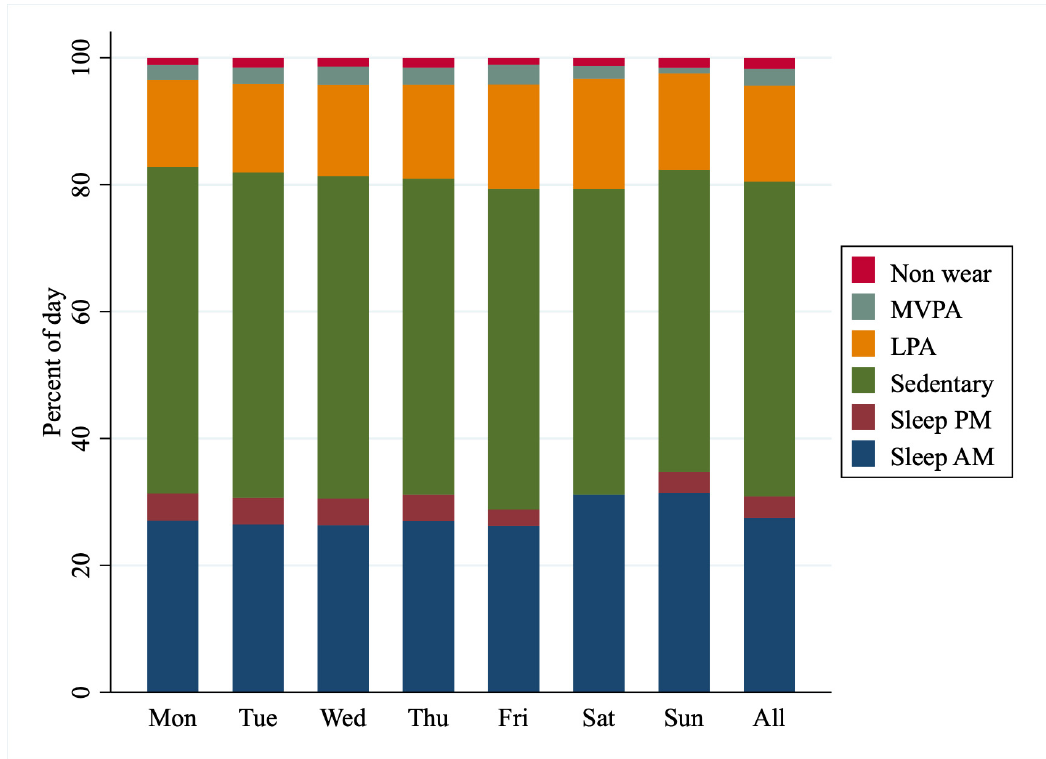
Figure 2. Median time spent sleeping, sedentary and engaging in light physical activity (LPA) or moderate-to-vigorous physical activity (MVPA) across days of the week, as measured by accelerometry in 119 New Zealand adolescent females. Number of valid days for each of the days of the week are as follows: Monday n = 94, Tuesday n = 90, Wednesday n = 68, Thursday n = 81, Friday n = 90, Saturday n = 100, Sunday n = 107.